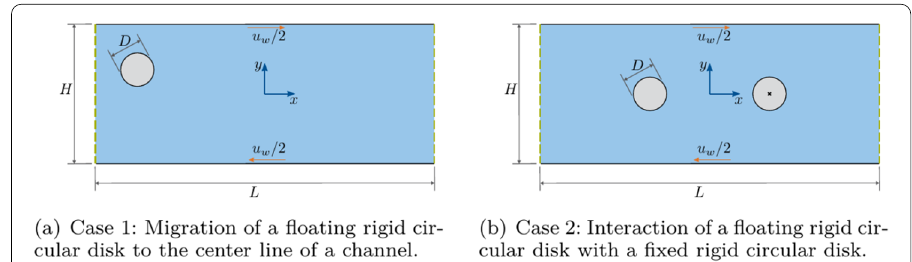
Fig. 7 A rigid circular disk floating in a shear flow: geometry and boundary conditions of two different cases